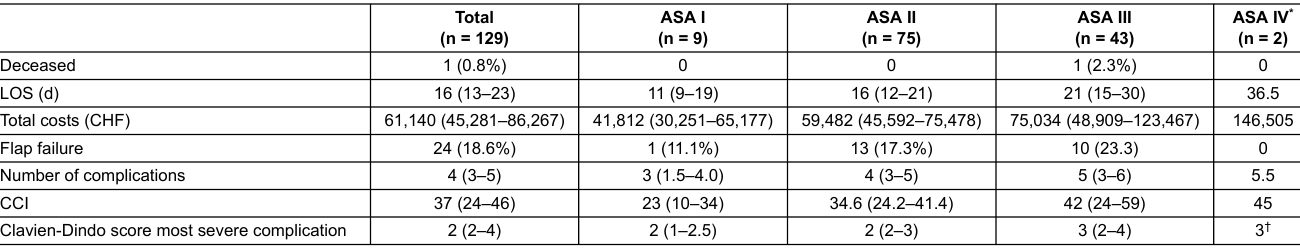
Table 2: Patient outcomes by pre-surgical ASA score (n = 129).